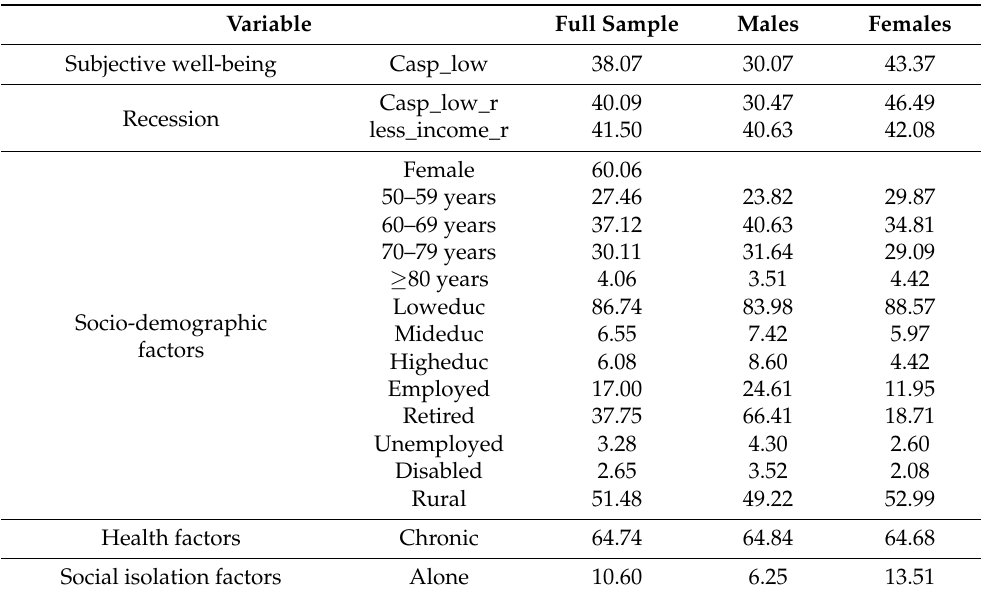
Table 2. Distribution of the analytical sample (%) ( n = 641; 256 males and 385 females). Variable Full Sample Males Females Subjective well-being